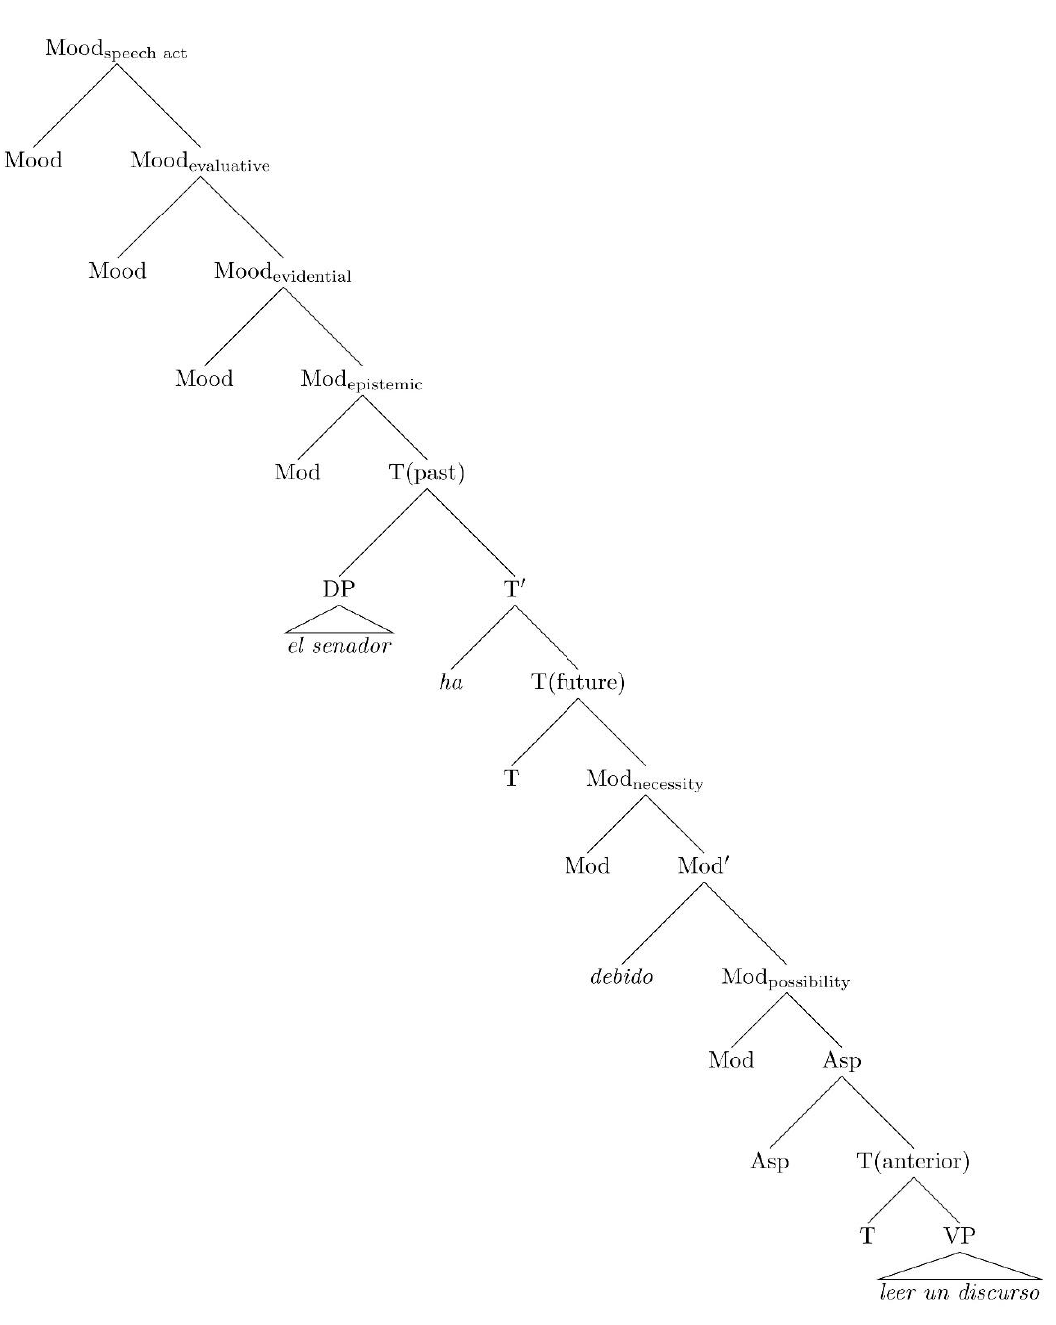
Figure 10. Cartographic clausal hierarchy